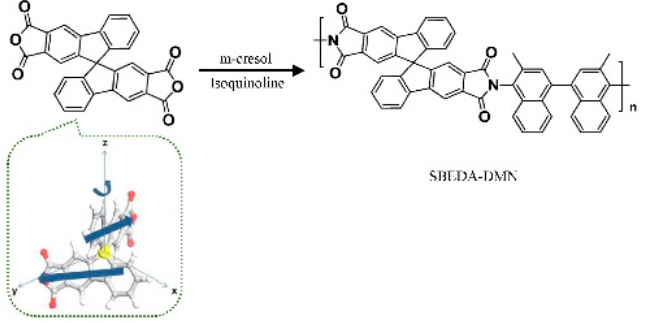
Figure 13. Synthesis of spirobifluorene dianhydride-dimethylnaphthidine (SBFDA-DMN). Adapted from Reference [83].